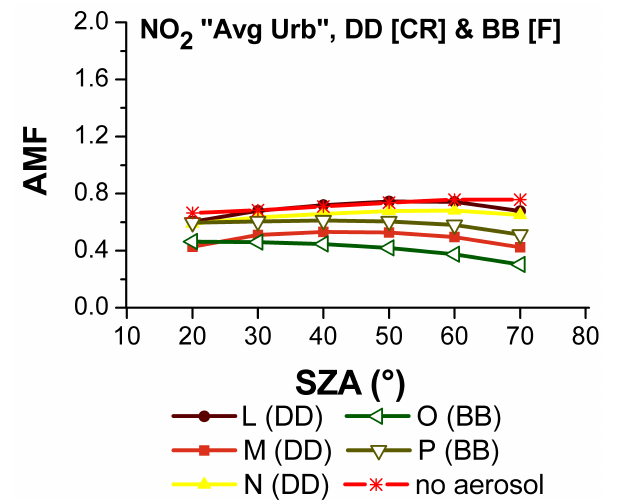
Fig. 10. NO 2 airmass factors for urban NO 2 profile from CHIMERE using no aerosol and also for scenarios L to P (mea- sured aerosol profiles) calculated with the phase functions deter- mined for desert dust (DD) coarse (CR) particles (optical properties taken from Saudi Arabia AERONET station) and for biomass burn- ing (BB) fine (F) particles (optical properties taken from Amazonian Forest/Brazil AERONET station). AMFs determined at 440nm, with surface albedo = 0.03, and ω 0 = 0.92 (L, O, P) and 0.93 (N) (in scenario M ω 0 varies in height from 0.80 to 0.95), and AOD = 1.05 (L, O), 0.66 (M), 0.16 (N) and 0.42 (P) (see Table 2).